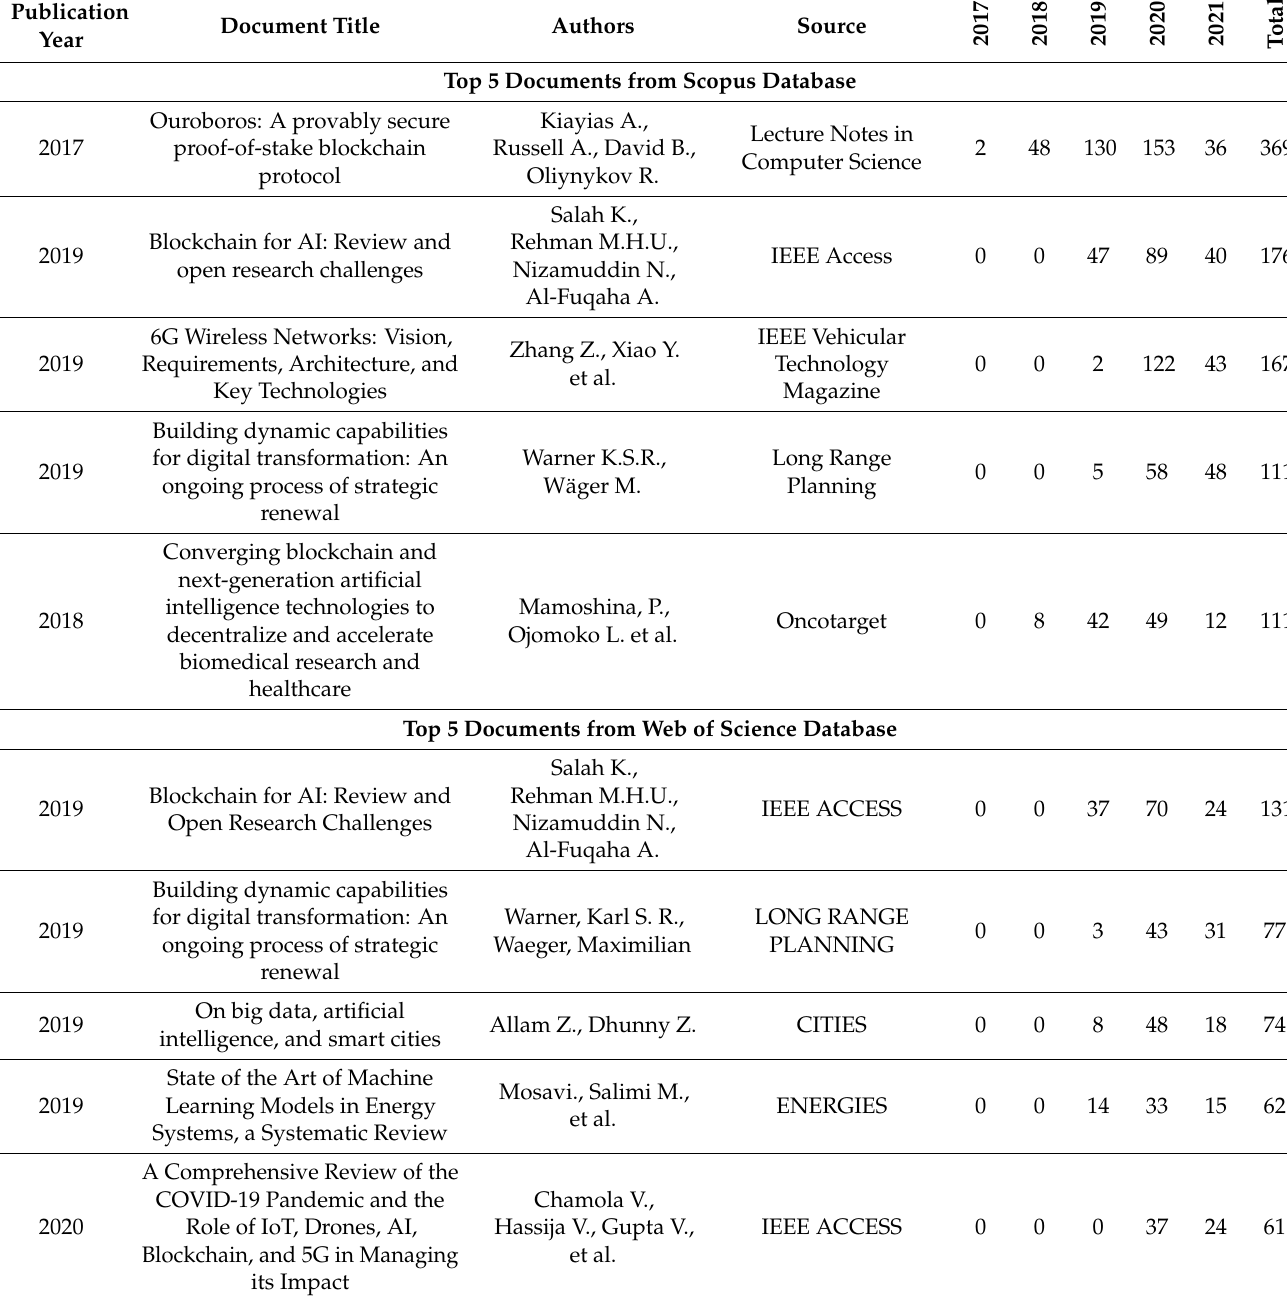
Table 3. Details of documents with highest number of